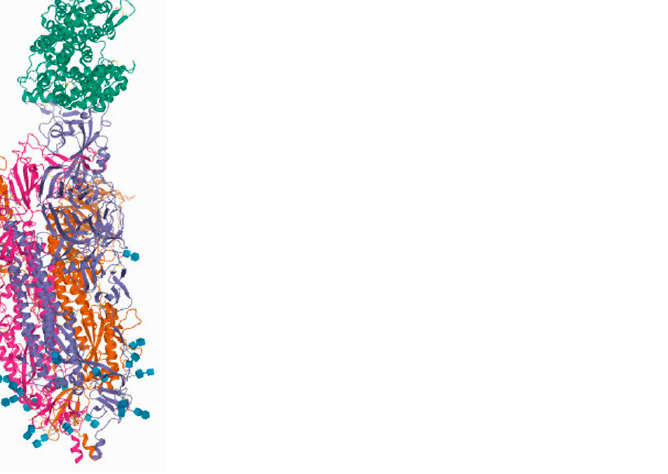
Figure 3. Structure of SARS-CoV-2/ACE 2 receptor complex. The upper, wider part is the S1 domain that interacts with the ACE2 receptor, colored in green, while the lower, narrower part is the S2 domain. Blue squares represent carbohydrates. Image obtained by Cong et al., 2021[55], PDB entry: 7DF4. Different strategies are being utilized to find the appropriate way to interrupt the proper function of S viral protein, including prevention of its binding to ACE2 receptor, inhibition of its fusion function, and inhibition of proteases responsible for its cleavage [53]. Antibodies, synthetic peptides, and other molecules, including polyphenols, are be- ing tested for this application. Considering that RBD domains of SARS-CoV and SARS- CoV-2 have about 75% homology in amino acid sequence, antibodies and molecules that target this domain might not be equally effective for both viruses [56]. 3.1.2. CL pro /M pro 3CL pro /M pro , Figure 4, is a nonstructural protein of coronaviruses in general. This en- zyme cleaves viral polyproteins, thus creating proteins required for virus replication and maturation. Two polypeptides named protomer A and B form a dimeric structure of 3CL pro . Each protomer is composed of three domains. Domains I and II have antiparallel β -barrel structure, while domain III has five α -helices. An extended loop region connects domains II and III. The location of Cys-His catalytic dyad of 3CL pro and substrate binding site is in a cleft between domains I and II. These structural characteristics are similar to M pro enzymes of other coronaviruses [57].